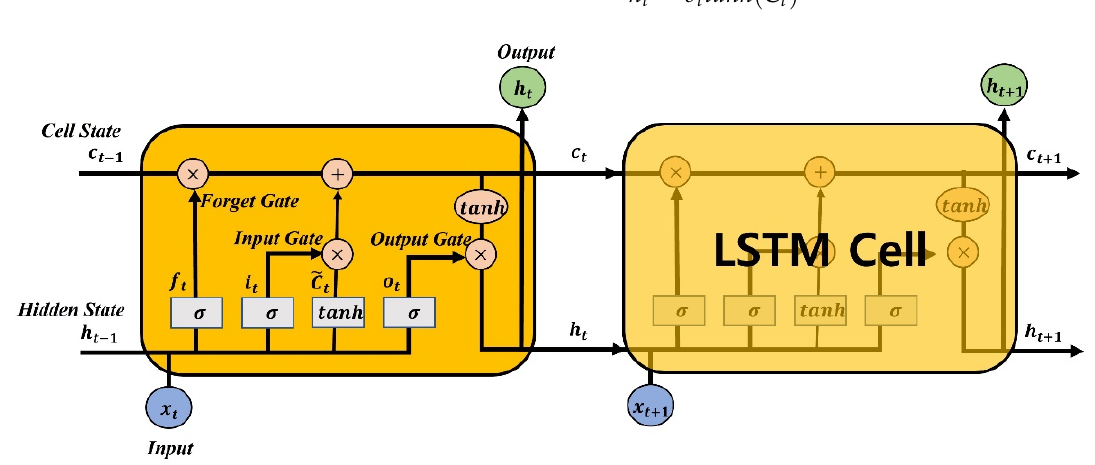
Figure 6. LSTM cell structure.